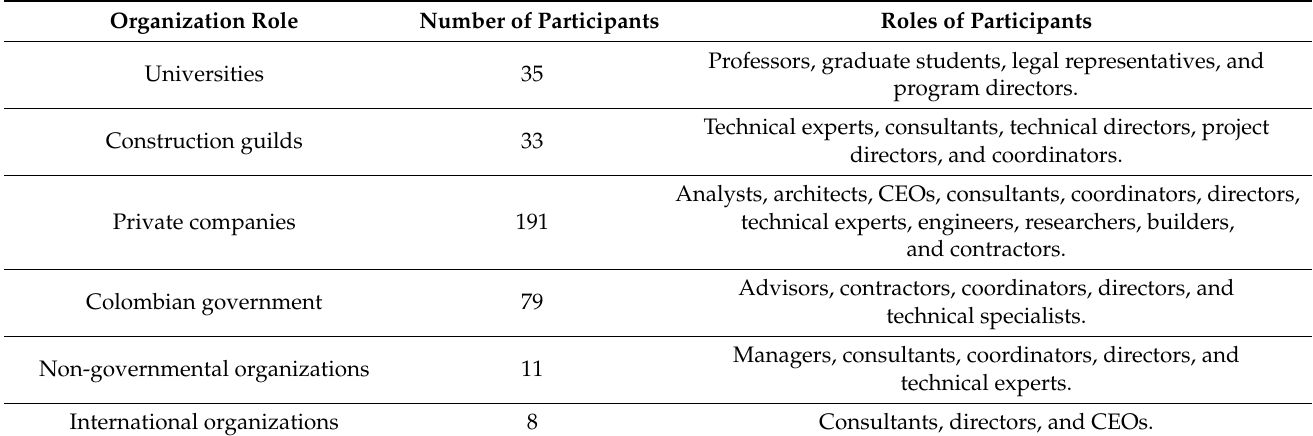
Table 1. Workshop